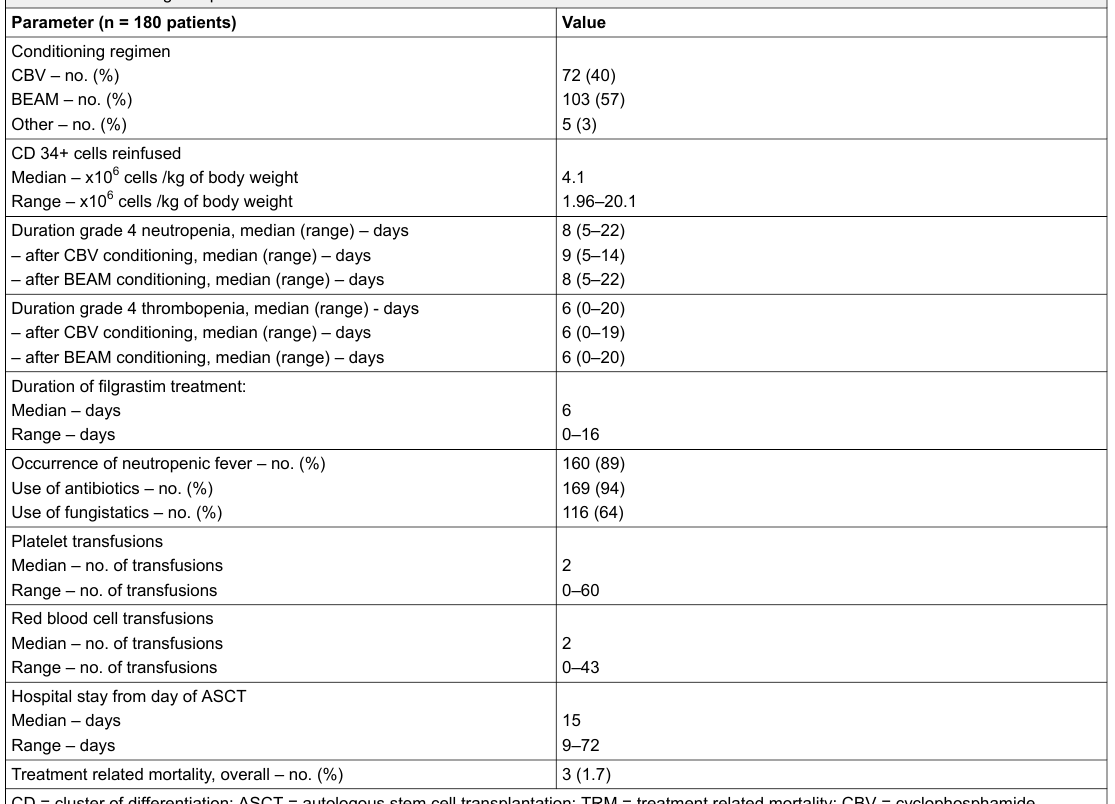
Table 2: Conditioning and post-ASCT